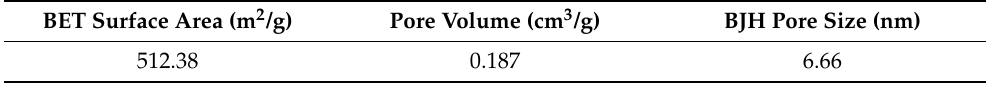
Table 1. Porous properties of